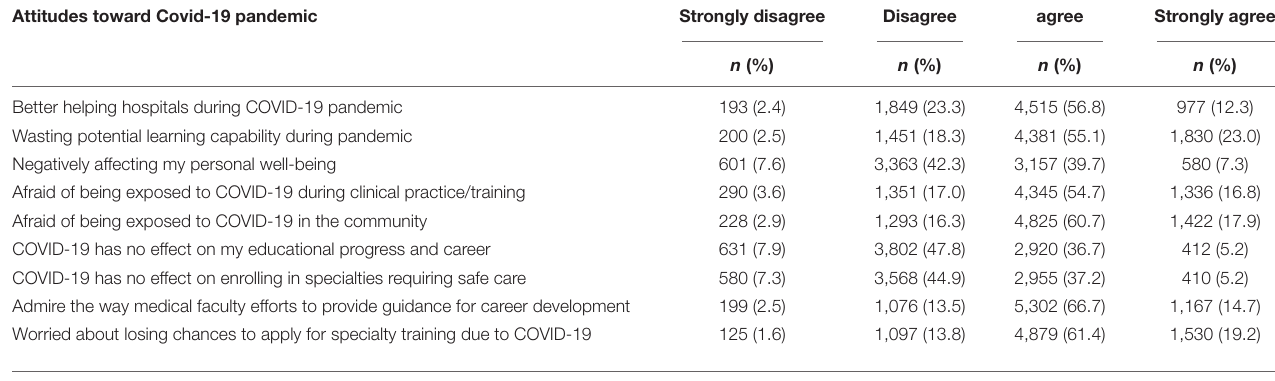
TABLE 5 | Knowledge of medical students toward e-learning.